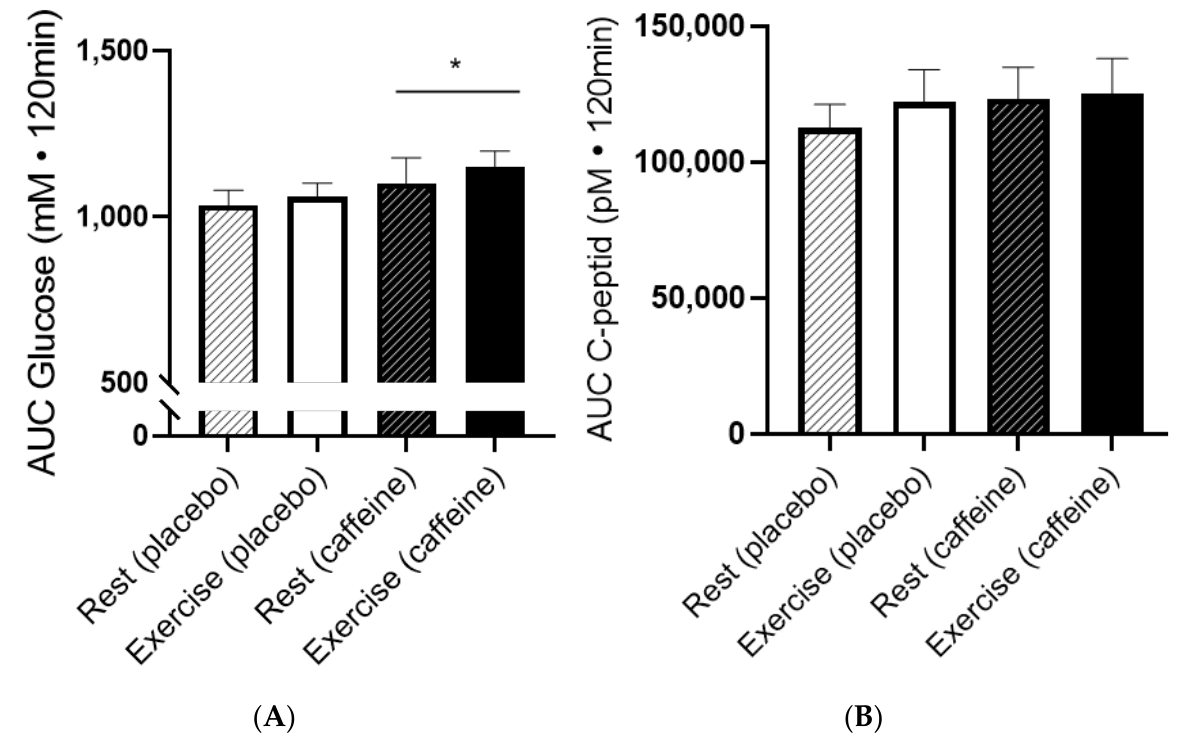
Figure 3. Effect of caffeine on glucose and C-peptide responses to OGTT on days with and without exercise the day before. ( A ) Area under curve (AUC) for glucose during the OGTT. ( B ) Area under curve for C-peptide during the OGTT. Data are mean ± SEM. N = 8. *: p < 0.05; Two-way ANOVA comparing AUC for glucose with and without caffeine.